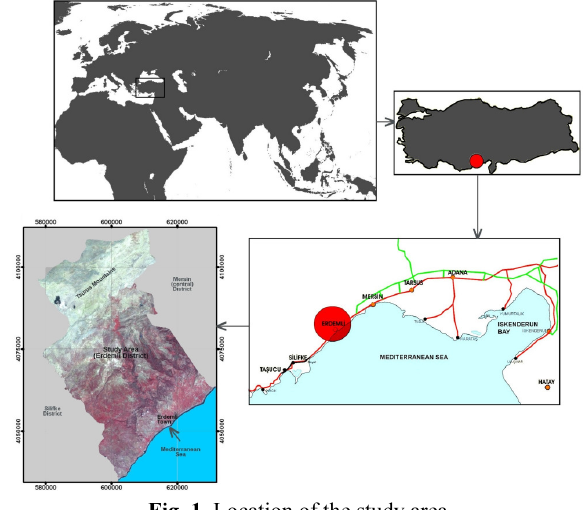
Fig. 1. Location of the study area